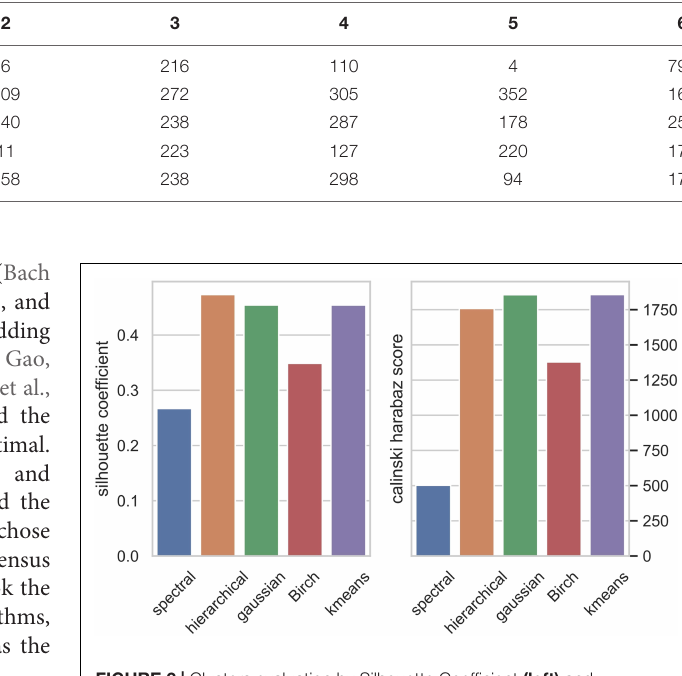
FIGURE 2 | Clusters evaluation by Silhouette Coefficient (left) and Cali´nski–Harabaz score (right) .